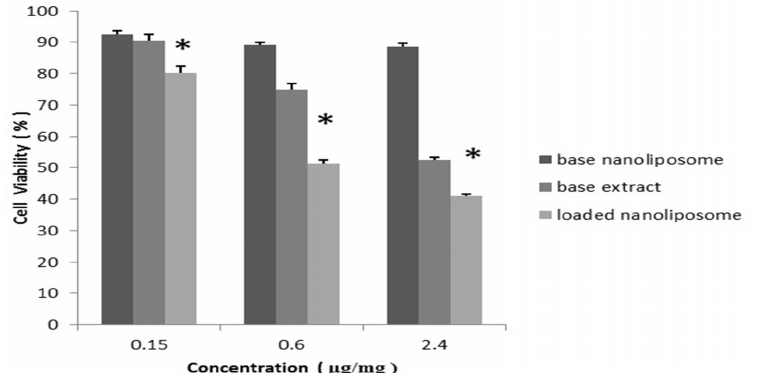
Fig. 3. MTT assay of nanoliposomal extract on AGS cell line after 24 h compared to base extract. Data are presented as mean ±SD. (n=3). ( *